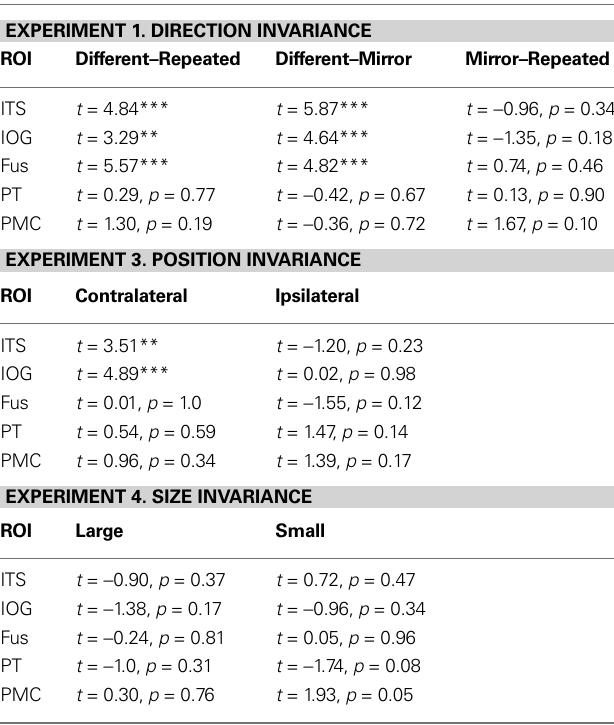
Table 3 | Statistical analyses for the remaining biological motion selective ROIs for Experiments 1, 3 and 4. Planned statistical contrasts were computed on from the timepoints surrounding the peak response, as deconvolved using a general linear analysis (see Section “Materials and